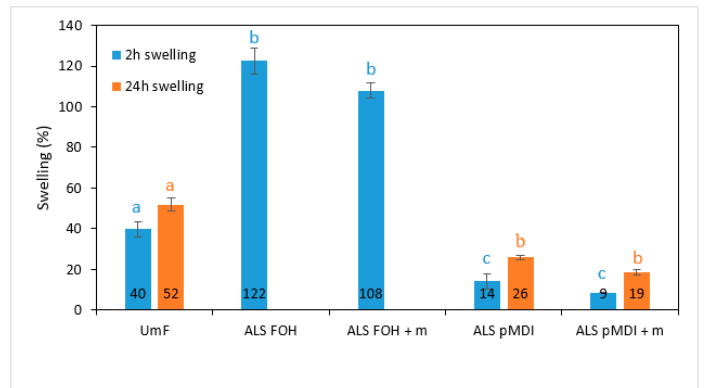
Figure 8. Thickness swelling of particleboards produced with urea-melamine-formaldehyde (UmF), ammonium lignosulfonate (ALS) crosslinked with furfuryl alcohol (ALS FOH), ALS FOH with mimosa tannin (ALS FOH + m), ALS crosslinked with pMDI (ALS pMDI) and ALS pMDI with mimosa tannin (ALS pMDI + m) after two hours (blue bars) and after 24 hours (orange bars). Error bars represent standard deviations. Values labeled with di ff erent letters (a, b and c) are statistically di ff erent at an error probability of α = 0.05 (ANOVA and Tukey’s HSD tests). Di ff erent colored letters refer to swelling property.